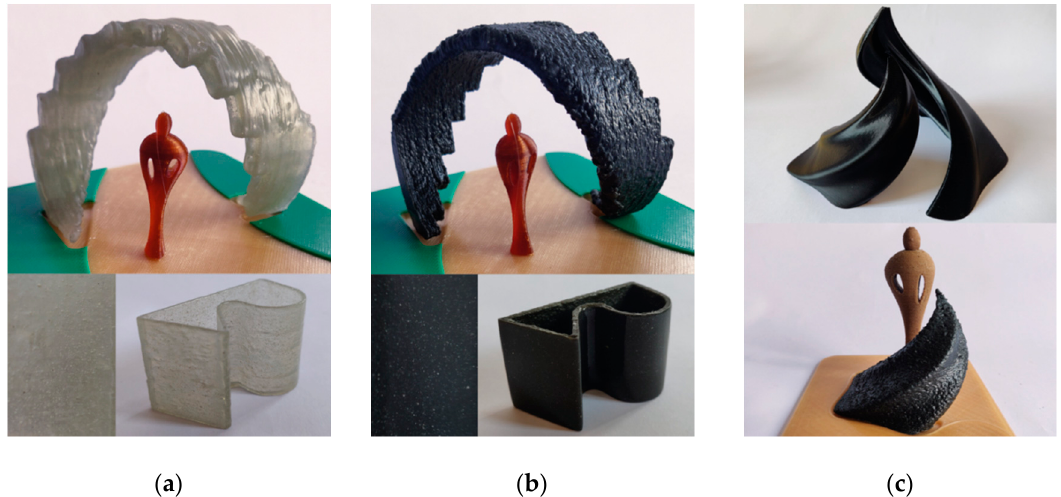
Figure 4. UV-assisted liquid deposition modeling (UV-LDM) additive manufacturing experimentation: ( a ) 1:50 scale model for amusement park application and polished surface finish sample made of 50FIL100; ( b ) 1:50 scale model for amusement park application and polished surface finish sample made of 55GAMF; ( c ) 1:20 scale FDM 3D-printed model of water decoration structures for urban design and amusement applications (top), and 1:20 scale UV-LDM model with 55GAMF (bottom).